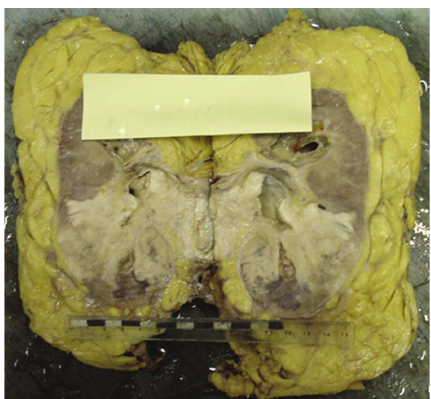
Figure 4: Lower pole of the left kidney largely replaced by a white friable tumour which appears to arise from the pelvicalyceal mucosa at the hilum. The tumour focally extends into hilar and perinephric